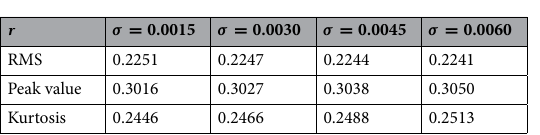
Table 2. Indicator reliability under different perturbation intensities.